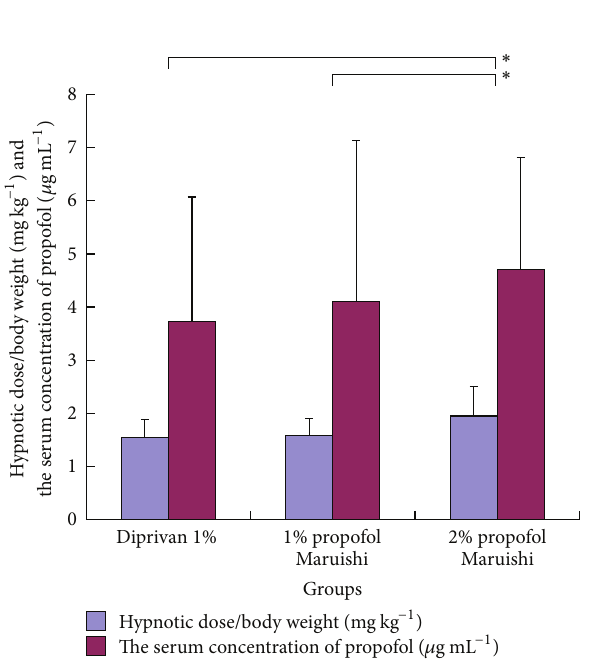
Figure 1: The results of the hypnotic dose of propofol and the serum concentration of propofol. The results were expressed as mean ± SD. ∗ 𝑝 < 0.05 between the groups.